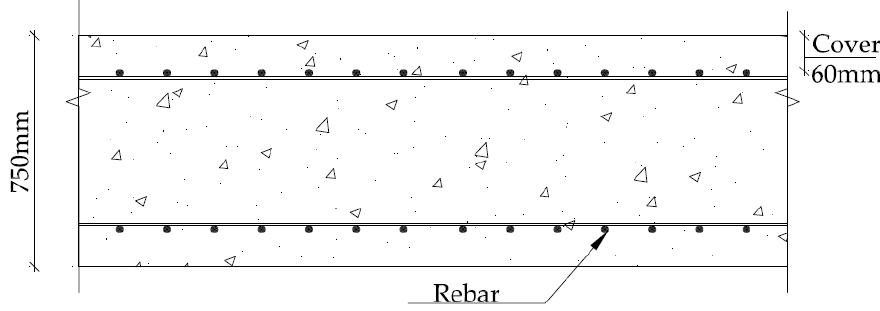
Figure 4. Cross-section for the example reinforced concrete deck.